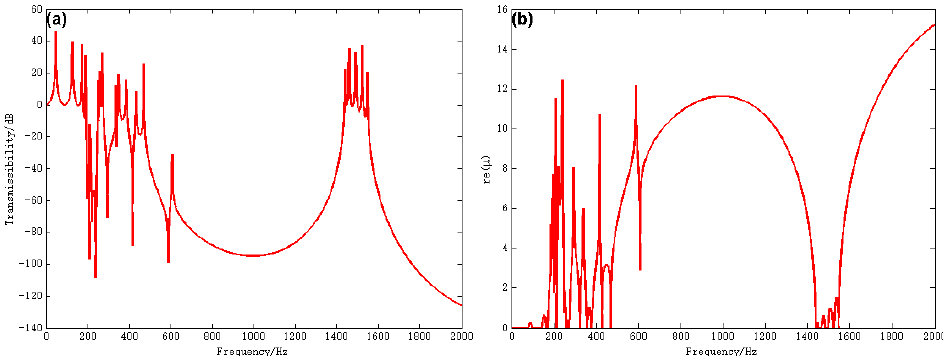
Figure 11. Band gap behavior of the reverse designed strut. ( a ) Transmission capability of the finite strut. ( b ) Attenuation constant of corresponding supercell.